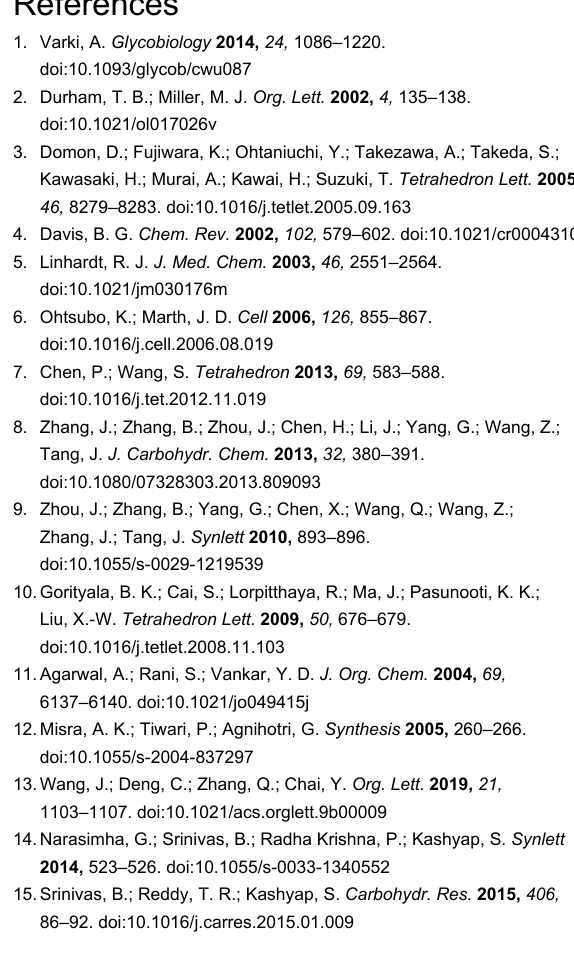
chair conformer and results in the observed α -selectivity of the 2,3-unsaturated glycosides III (Figure 4) [22]. However, the ad- dition of the nucleophiles from the β -face gives the higher energy twist-boat